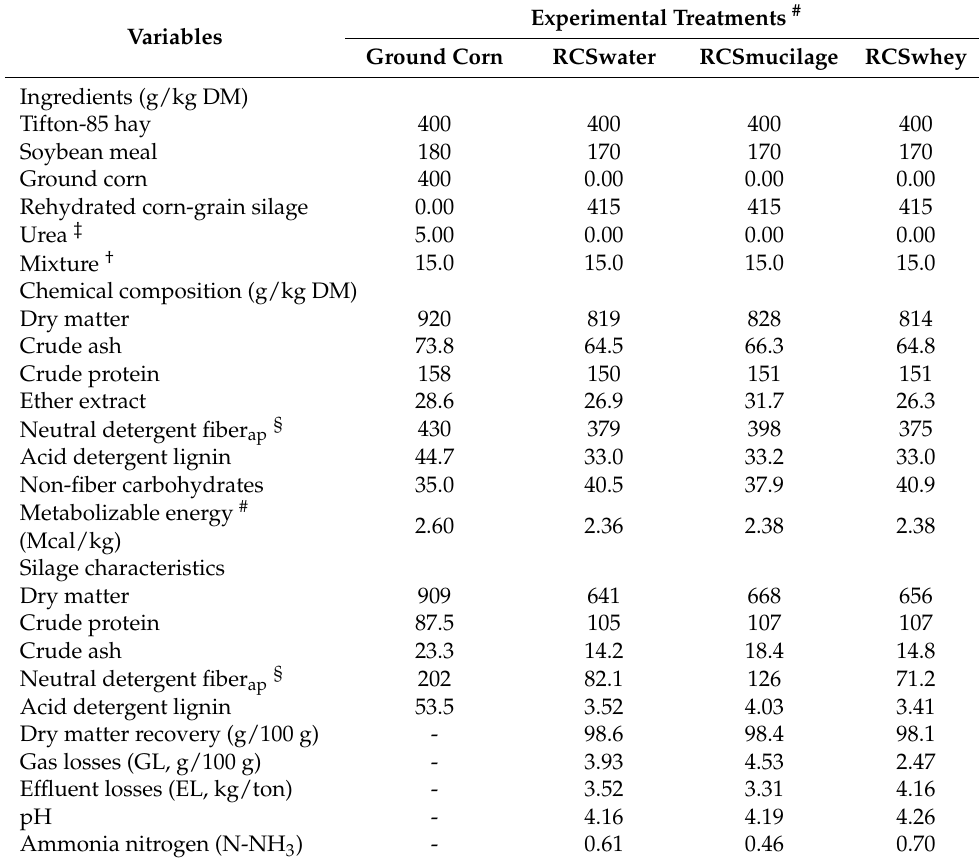
Table 1. Ingredient proportions and chemical composition of experimental diets and silages’ charac-